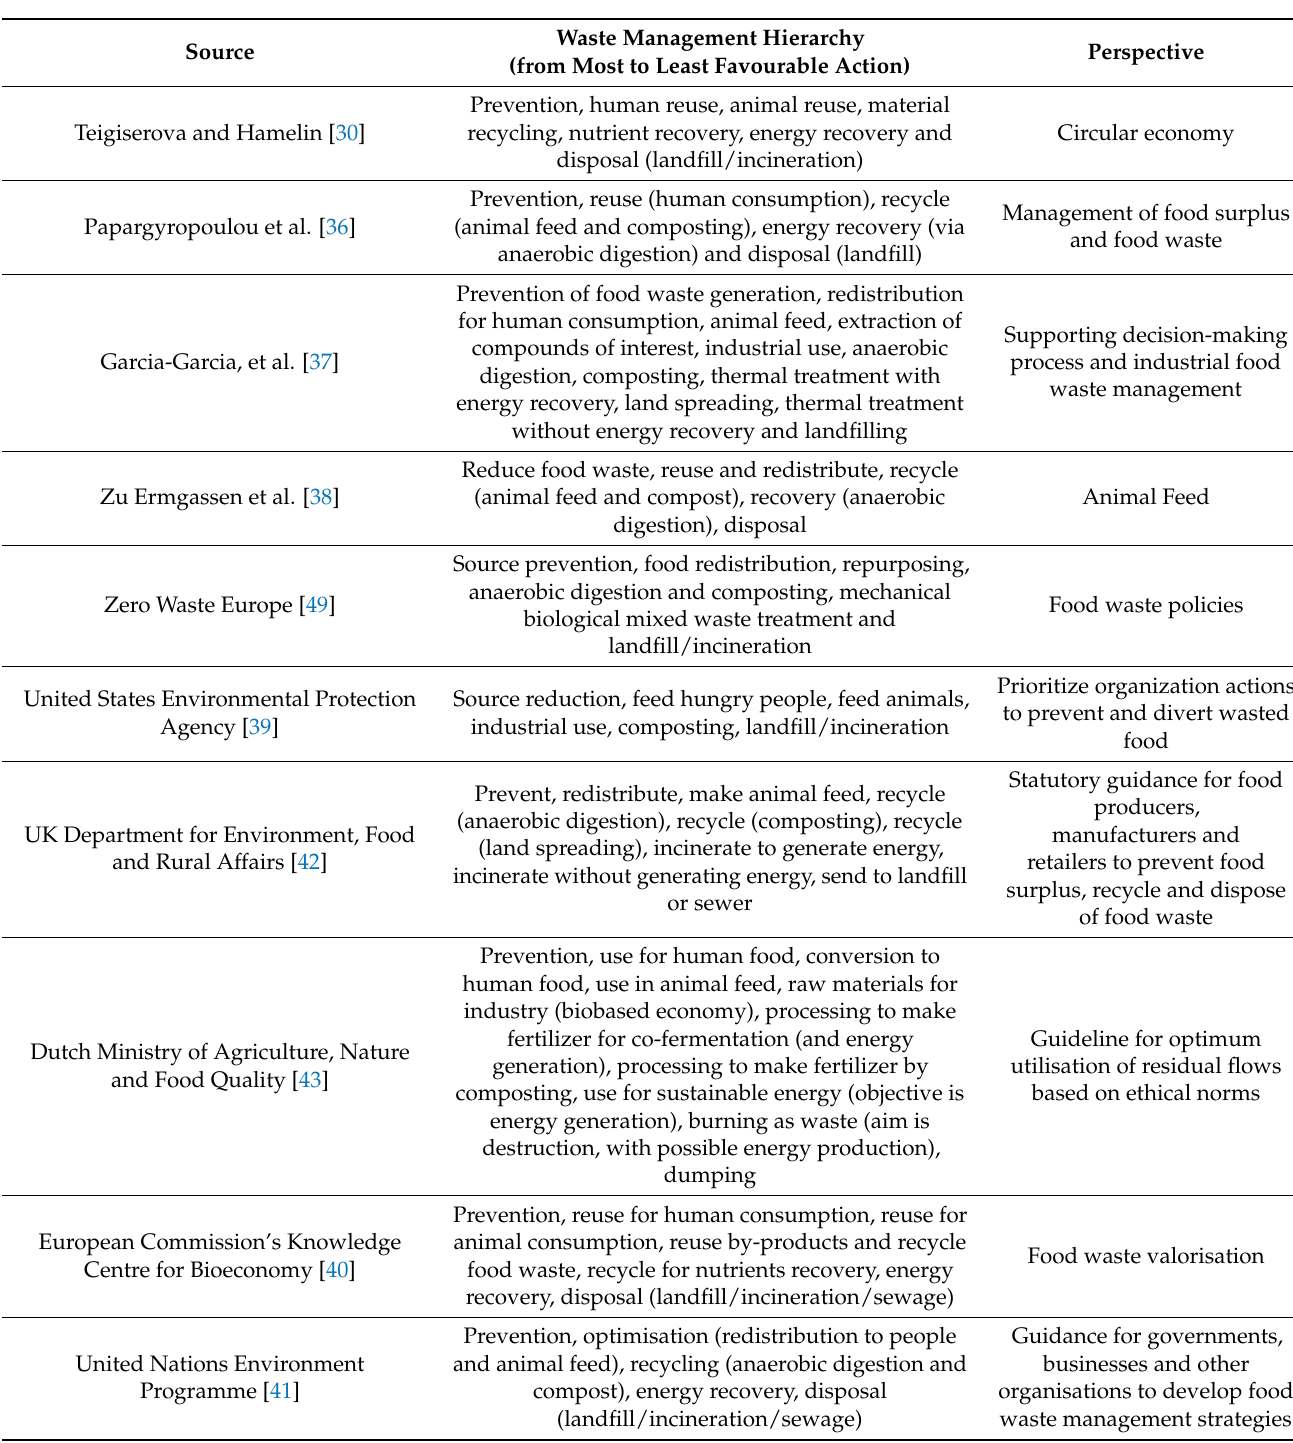
Table 2. Food waste management hierarchies from different